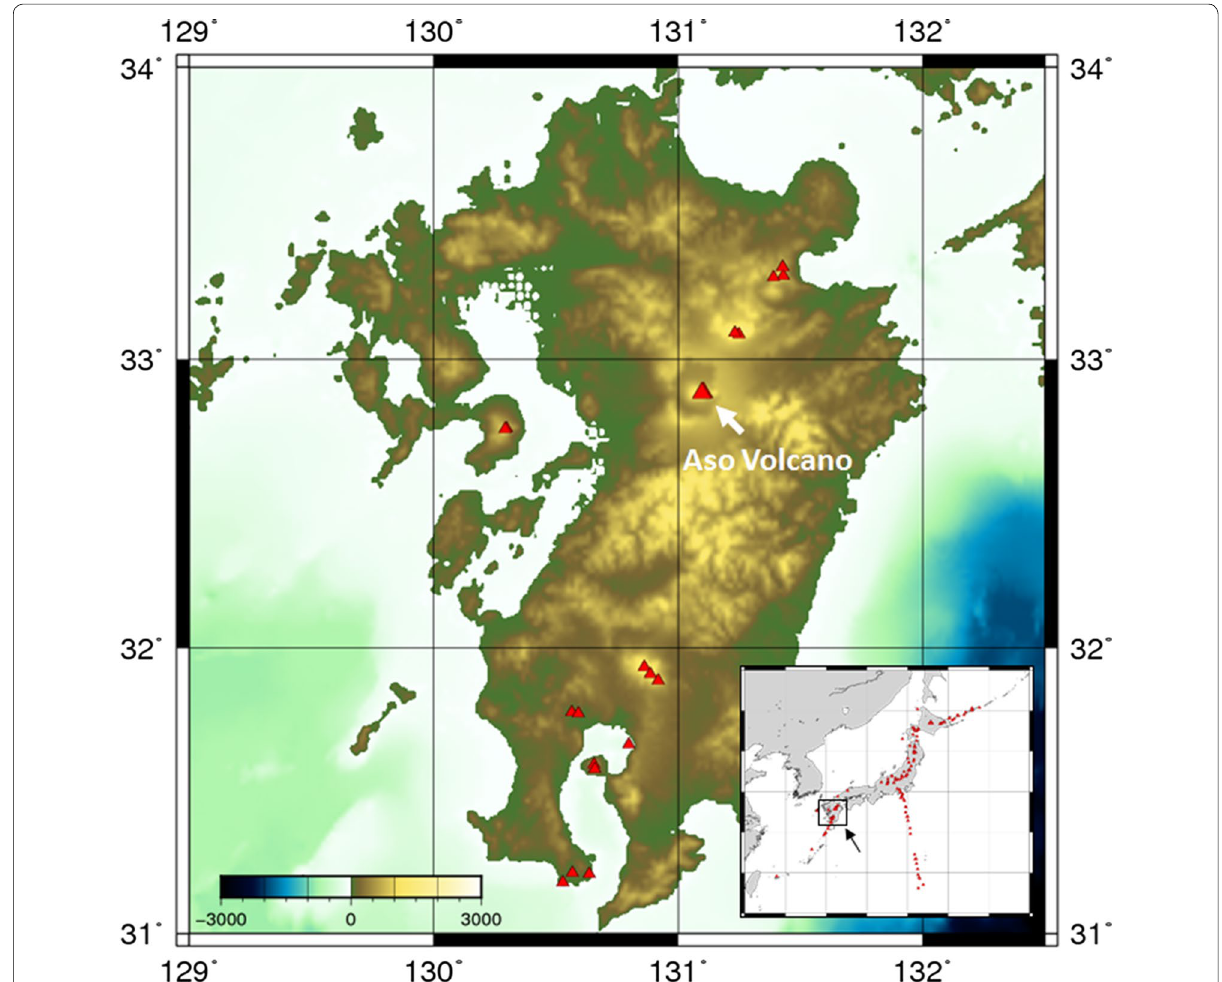
Fig. 1 Map of the Aso volcano. The large triangle indicates Aso volcano. The smaller triangles indicate other